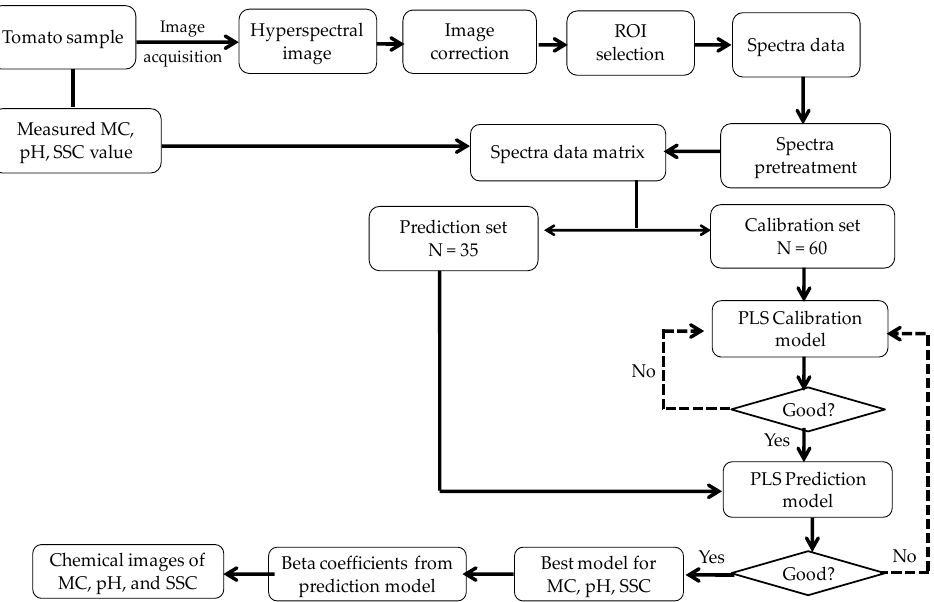
Figure 1. Key steps in the full procedure for predicting the moisture content (MC), pH and soluble solid content (SSC) in intact tomatoes.